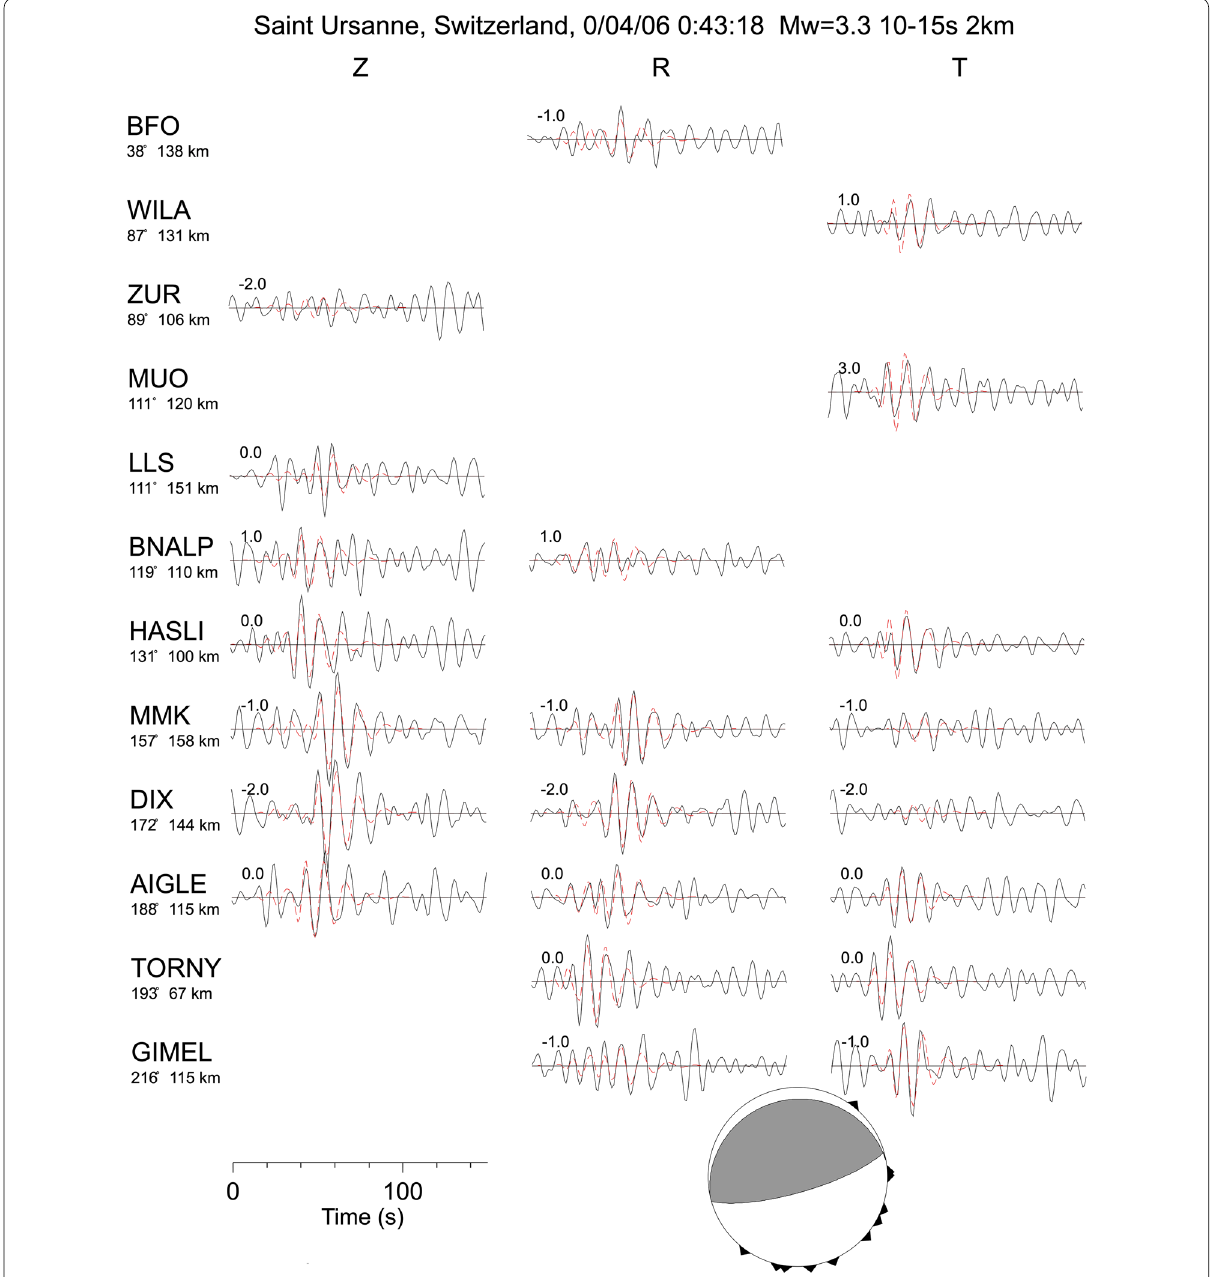
Fig. 9 Full-waveform moment-tensor solution for the mainshock of the Saint-Ursanne seismic sequence (April 6th, 2000). The strike, dip and rake of the two nodal planes are 074/076/89 and 259/014/95. From J. Braunmiller (pers.